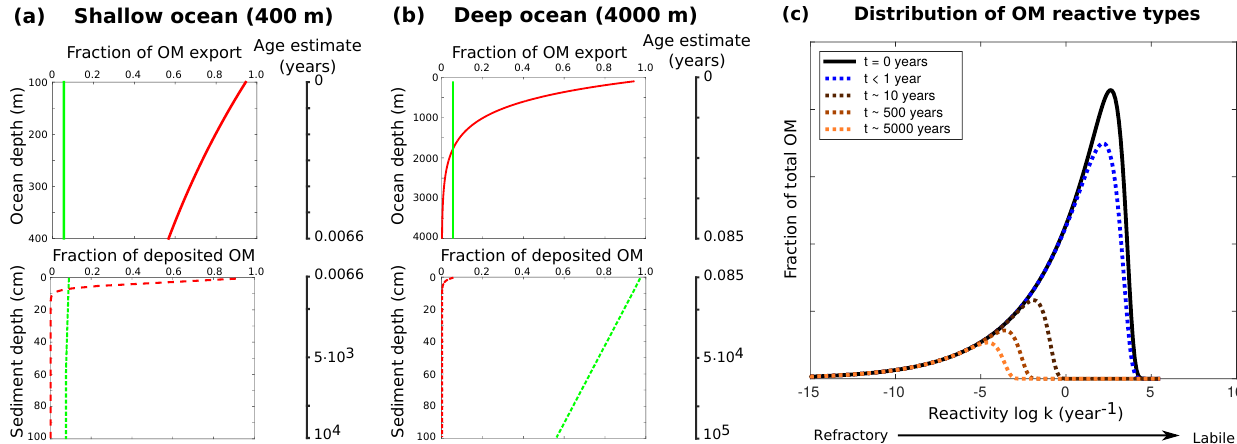
Figure 10. Idealised relationship of organic matter decomposition during remineralisation in the water column and the sediments. (a, b) Upper panels: water column development of the two organic matter fractions as represented in cGENIE for two ocean depths (red: labile OM with degradation length scale of 589m; green: refractory OM, which is unreactive in the water column). The values are normalised to OM export at 100m. Age estimates for the OM since its export from the euphotic zone are calculated using a sinking velocity of 125mday − 1 . (a, b) Lower panels: schematic representation of the development of the two OM fractions in the sediments (normalised to OM deposited on the sea floor). For the age estimates in the sediment column a sediment accumulation rate of 0.01 and 0.001cmyr − 1 is assumed. (c) Ide- alised distribution functions of OM reactive types during remineralisation for different OM ages assuming a reactive continuum model for OM degradation. The initial distribution (at t = 0) represents fresh OM when it is exported from the euphotic zone (characterised by a = 3 e − 4 yr − 1 and ν = 0 . 125; Boudreau et al.,